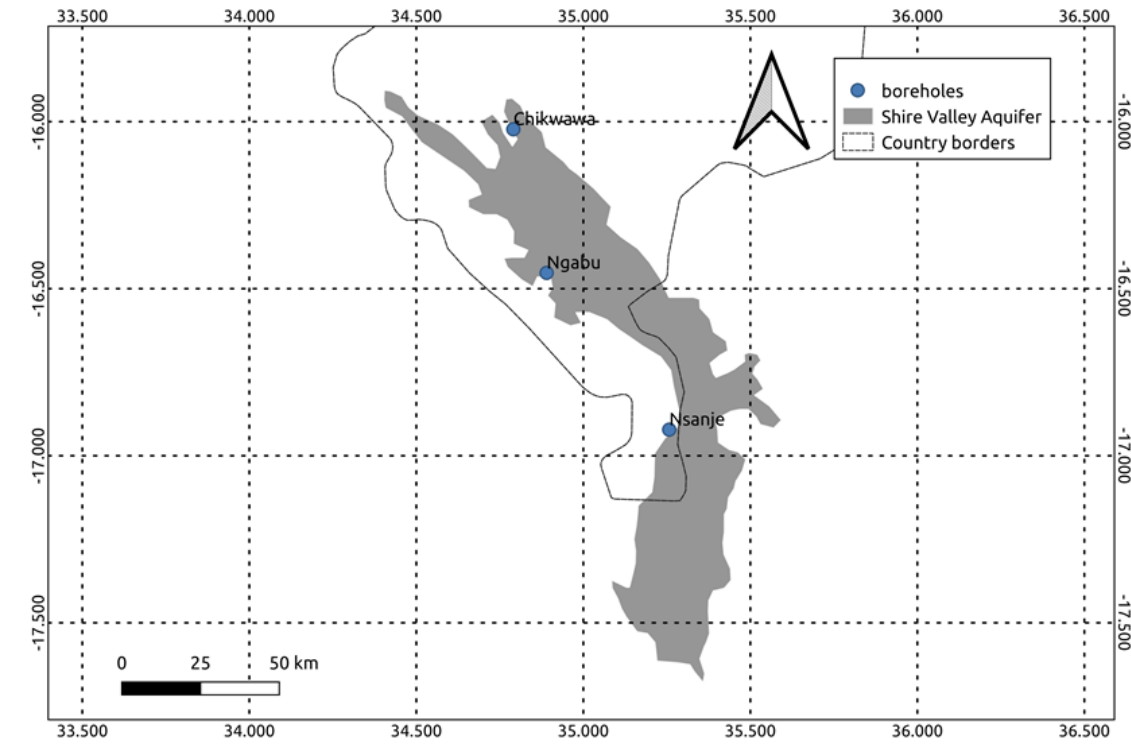
Figure 4. Groundwater level monitoring points within the Shire Valley Alluvial Aquifer.